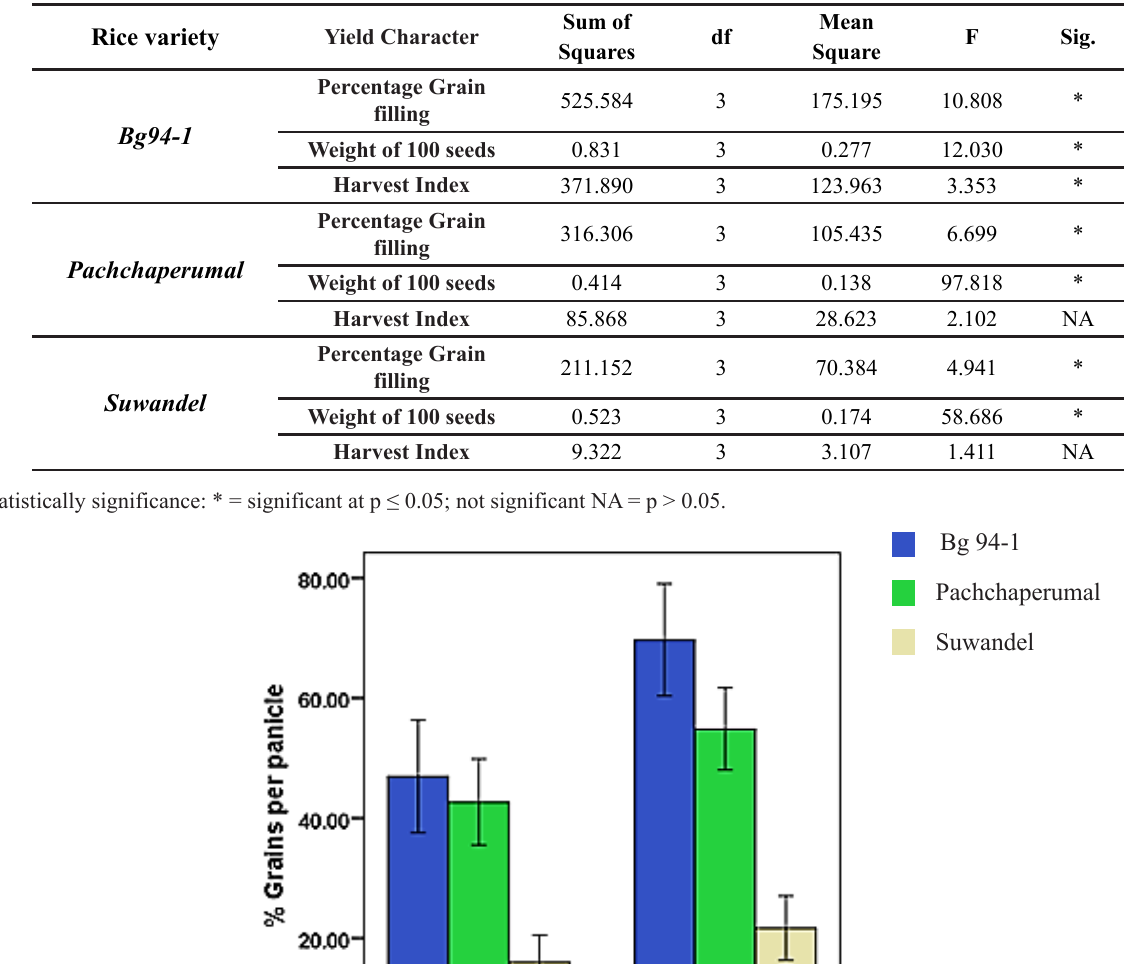
Table 5 : Summary of the one–way ANOVA performed on percentage grain filling, weight of 100 seeds and Harvest Index for Bg94-1 , Pachchaperumal and Suwandel rice varieties for nano-ZnO 60 mg L -1 and 120 mg L -1